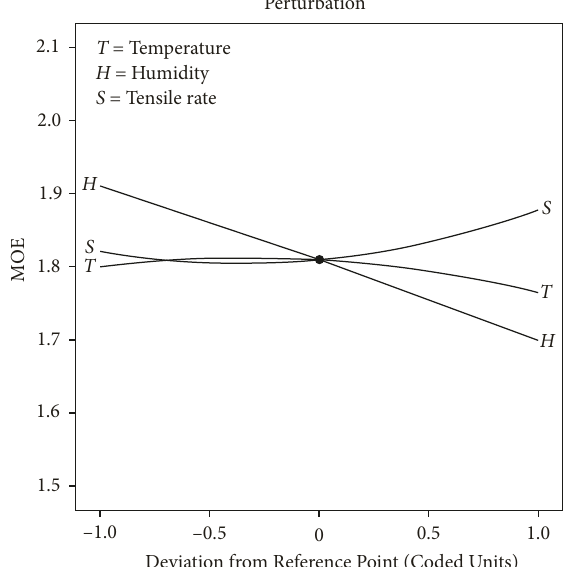
Figure 3: Change in MOE at different processing